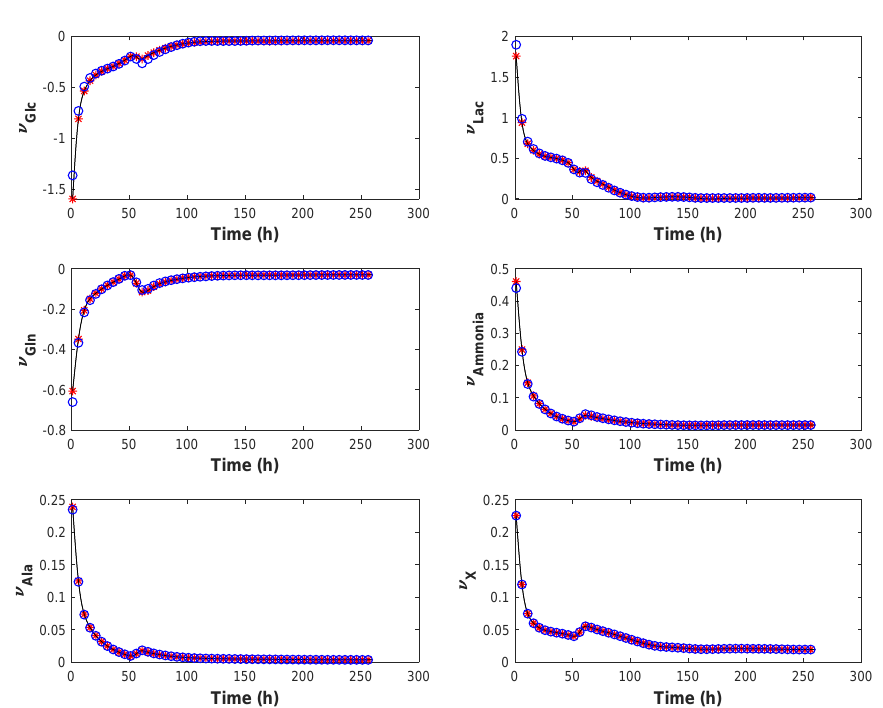
Figure 7. Time evolution of the experimental uptake and excretion rates (in mM · h − 1 ) in dataset # 2—numerical results (black curves); K e Φ for n EFM = 10 (red crosses); K e Φ for n EFM = 5 (blue bullets).